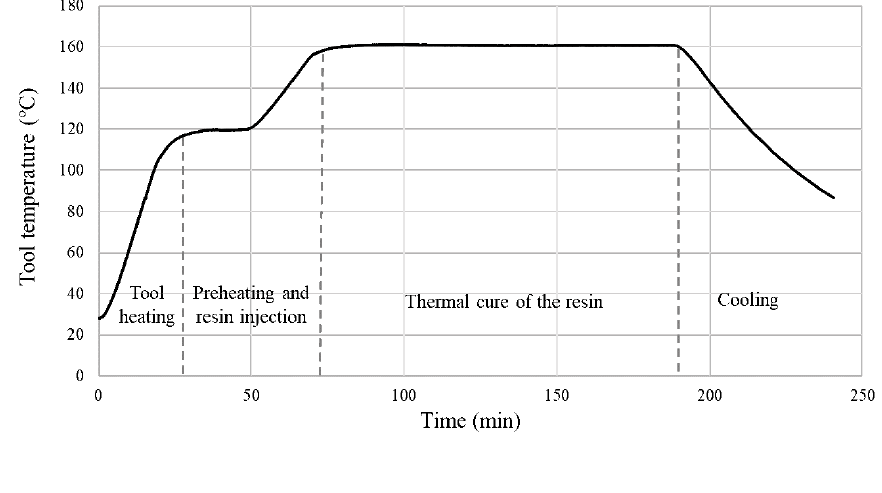
Figure 5: Resin cure curve.